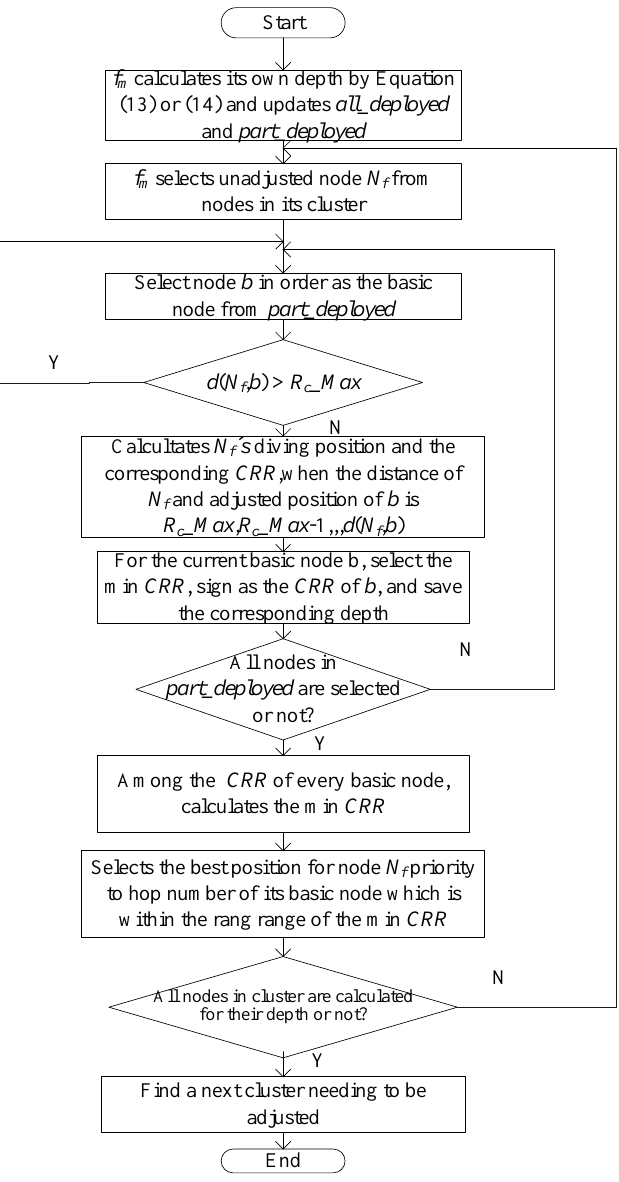
Figure 5. Flow chart of Section 3.2.3.